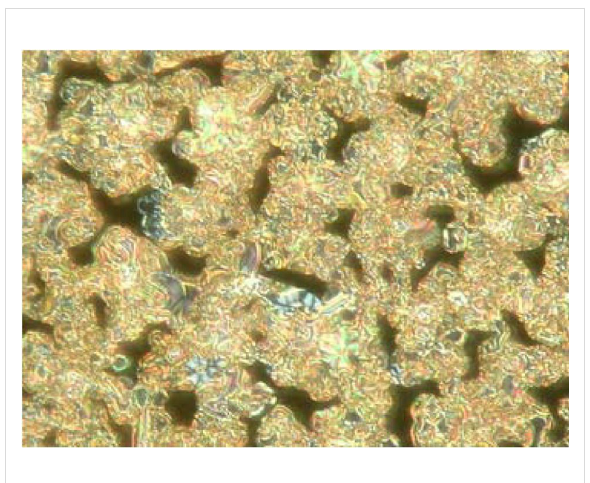
Figure 24: On cooling the isotropic liquid phase of compound OH 6c ; a Schlieren texture together with fringe pattern appears characteristic for SmCP A